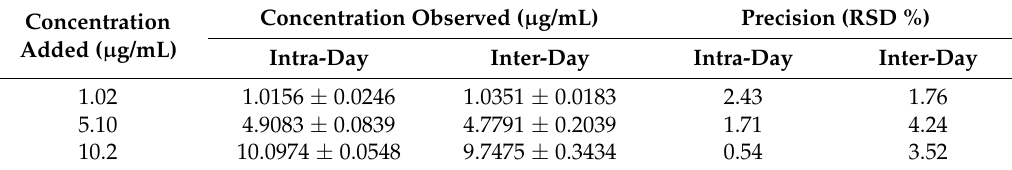
Table 4. Intra- and inter-day precision of Oxy-Di-OA in rat plasma (mean ± SD, n = 5). Concentration Observed ( µ g/mL) Precision (RSD %) Concentration Added ( µ g/mL) Intra-Day Inter-Day Intra-Day Inter-Day 1.02 1.0156 ± 0.0246